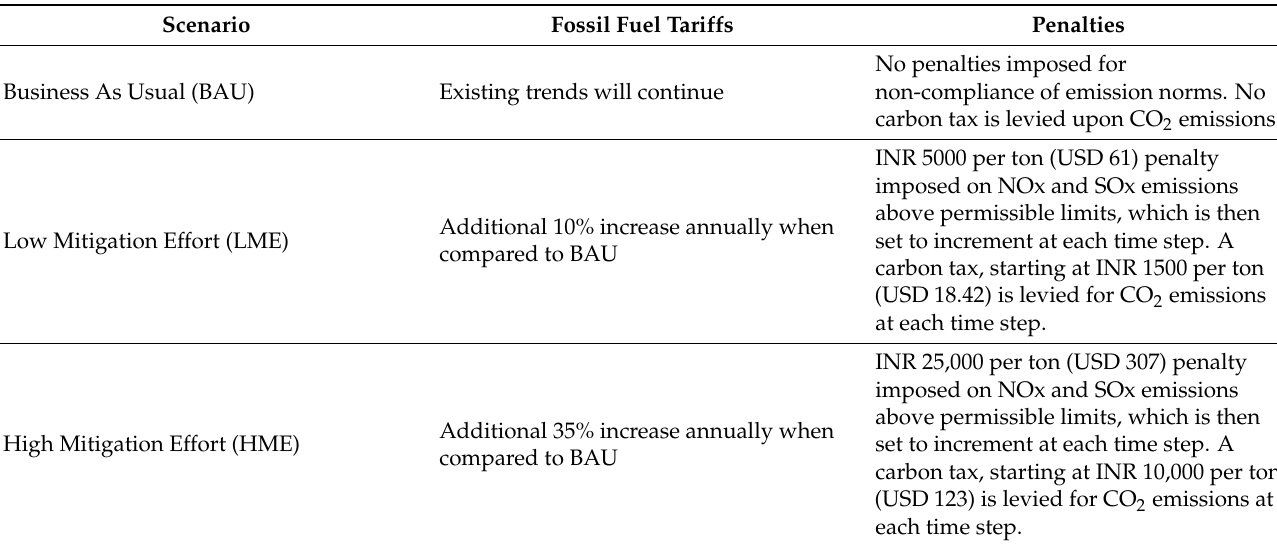
Table 1. Summary of the chosen scenarios for experimentation.